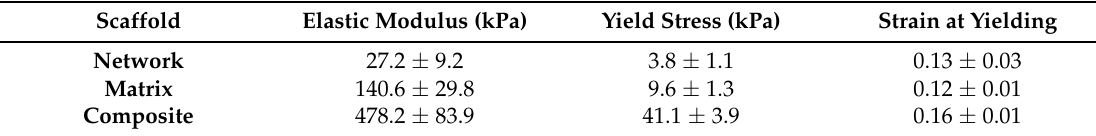
Figure 1. Results from unconfined compression tests of ( A ) network scaffolds ( B ) corresponding data from matrix hydrogels, and ( C ) composite scaffolds in the study ( n = 5). Table 1. Mechanical properties of network, matrix, and composite scaffolds.